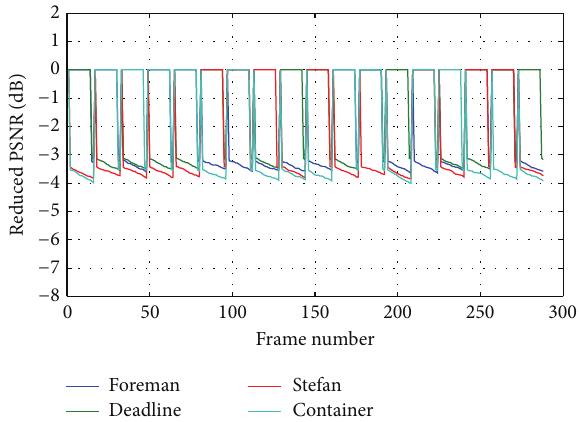
Figure 10: PSNR reduction when two descriptions are lost in each GOP.